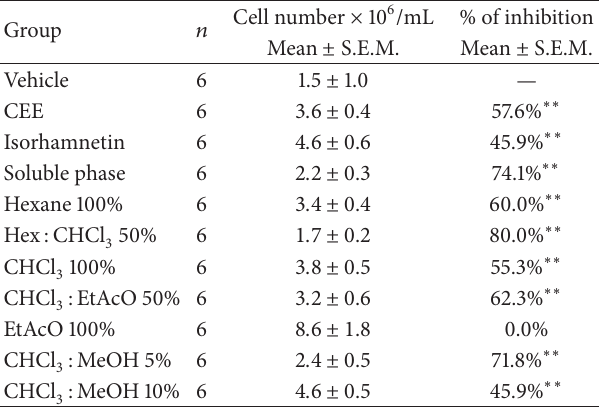
Table 5: Effects of extract, fractions (100mg/kg, p.o.), and